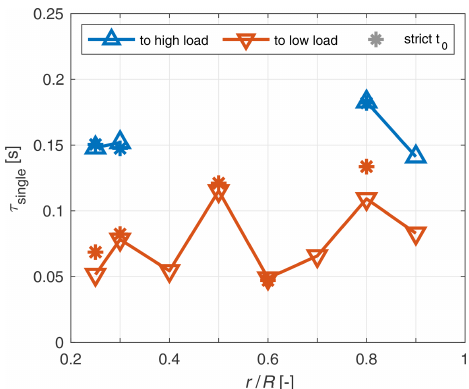
Figure 14. One-time-constant model fit of τ single to the tangential wake induction over the radius for both pitch